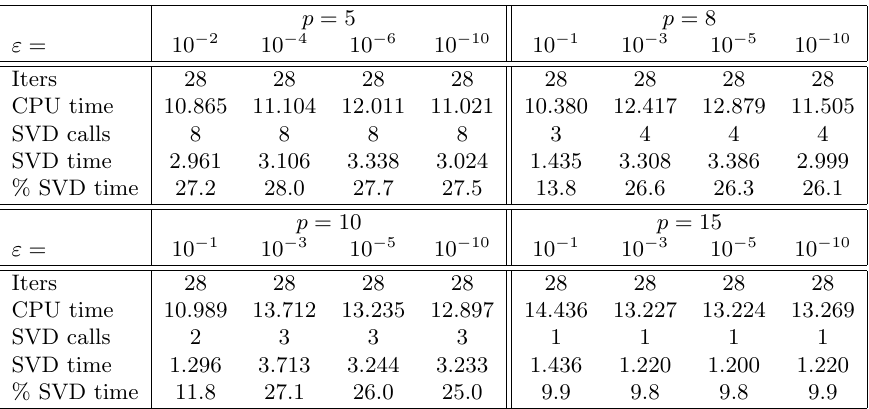
Table 1. Performance of the DBRR method for Problem 1.